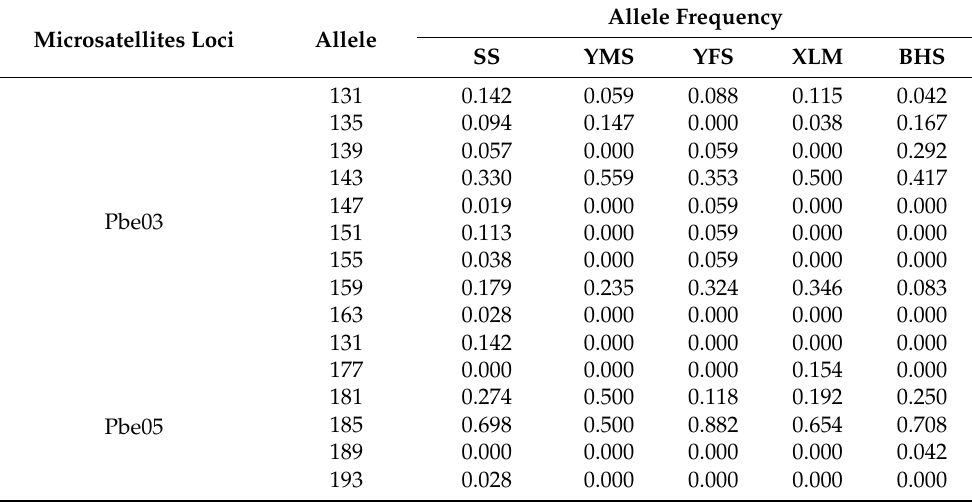
Table 2. Allele frequencies of six microsatellites in leopard cat subpopulations in the five sampling